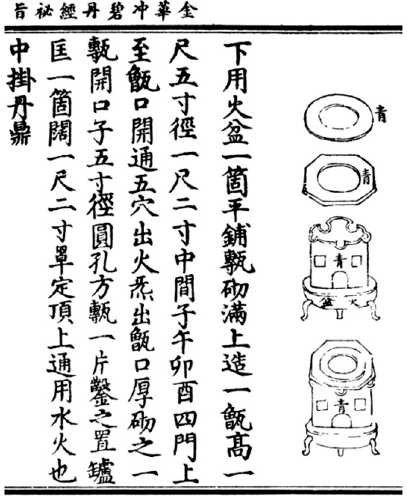
Figure 5. The Seventh Reverted Elixir of Pervading Mystery in the Five Great Mountains ( Huandan diqi zhuan wuyue tongxuan dan 還丹第七轉五嶽通玄丹 ) and the diagram of its refiner (Bai 1988b, p. 167a).